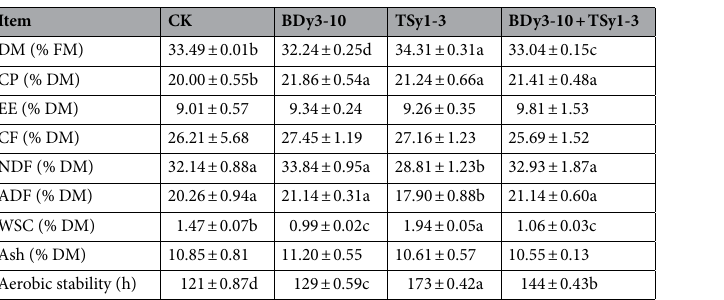
Table 6. Chemical composition and aerobic stability after 40 days of ensiling. Values with different lowercase letters show significant ( P < 0.05) differences in the same treatment. CK control, BDy3-10 L. rhamnosus , TSy1-3 L.